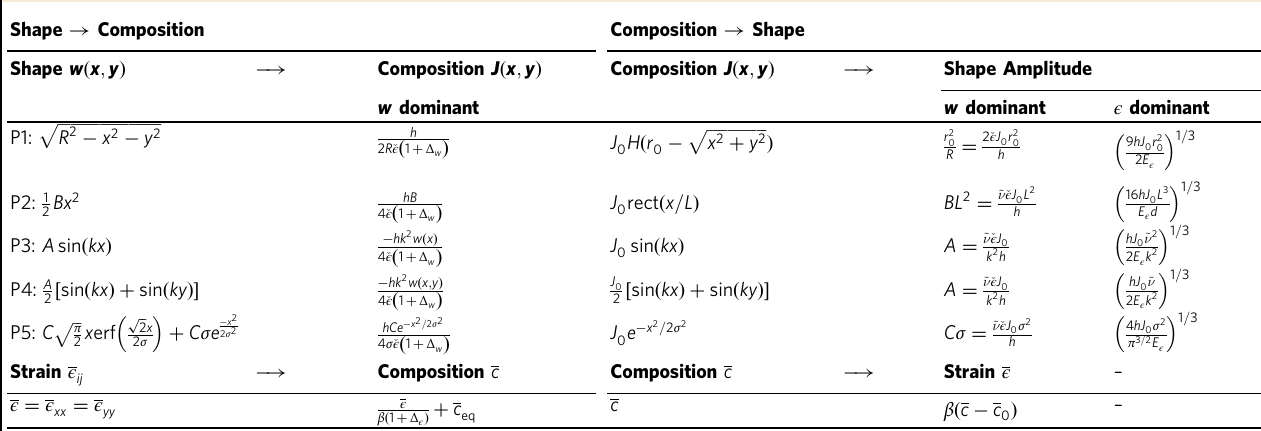
Table 1 Equilibrium mappings for shape ! composition programming and composition ! shape programming Shape ! Composition Composition ! Shape